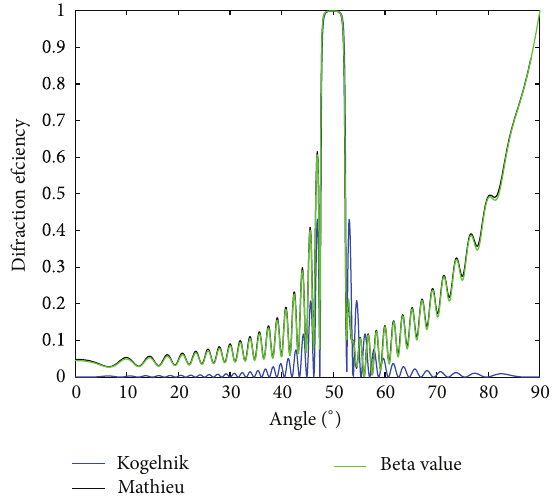
Figure 7: Diffraction efficiency of a reflection grating partially index-matched with thickness of 27 𝜇 m, spatial frequency of 3700 lines/mm, average refractive index 𝑛 = 1.5 , and refractive index modulation of II